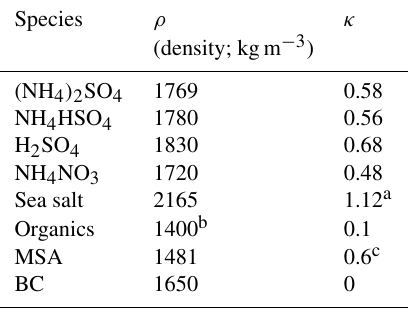
Table 2. The κ values and densities of the chemical species consid- ered in the